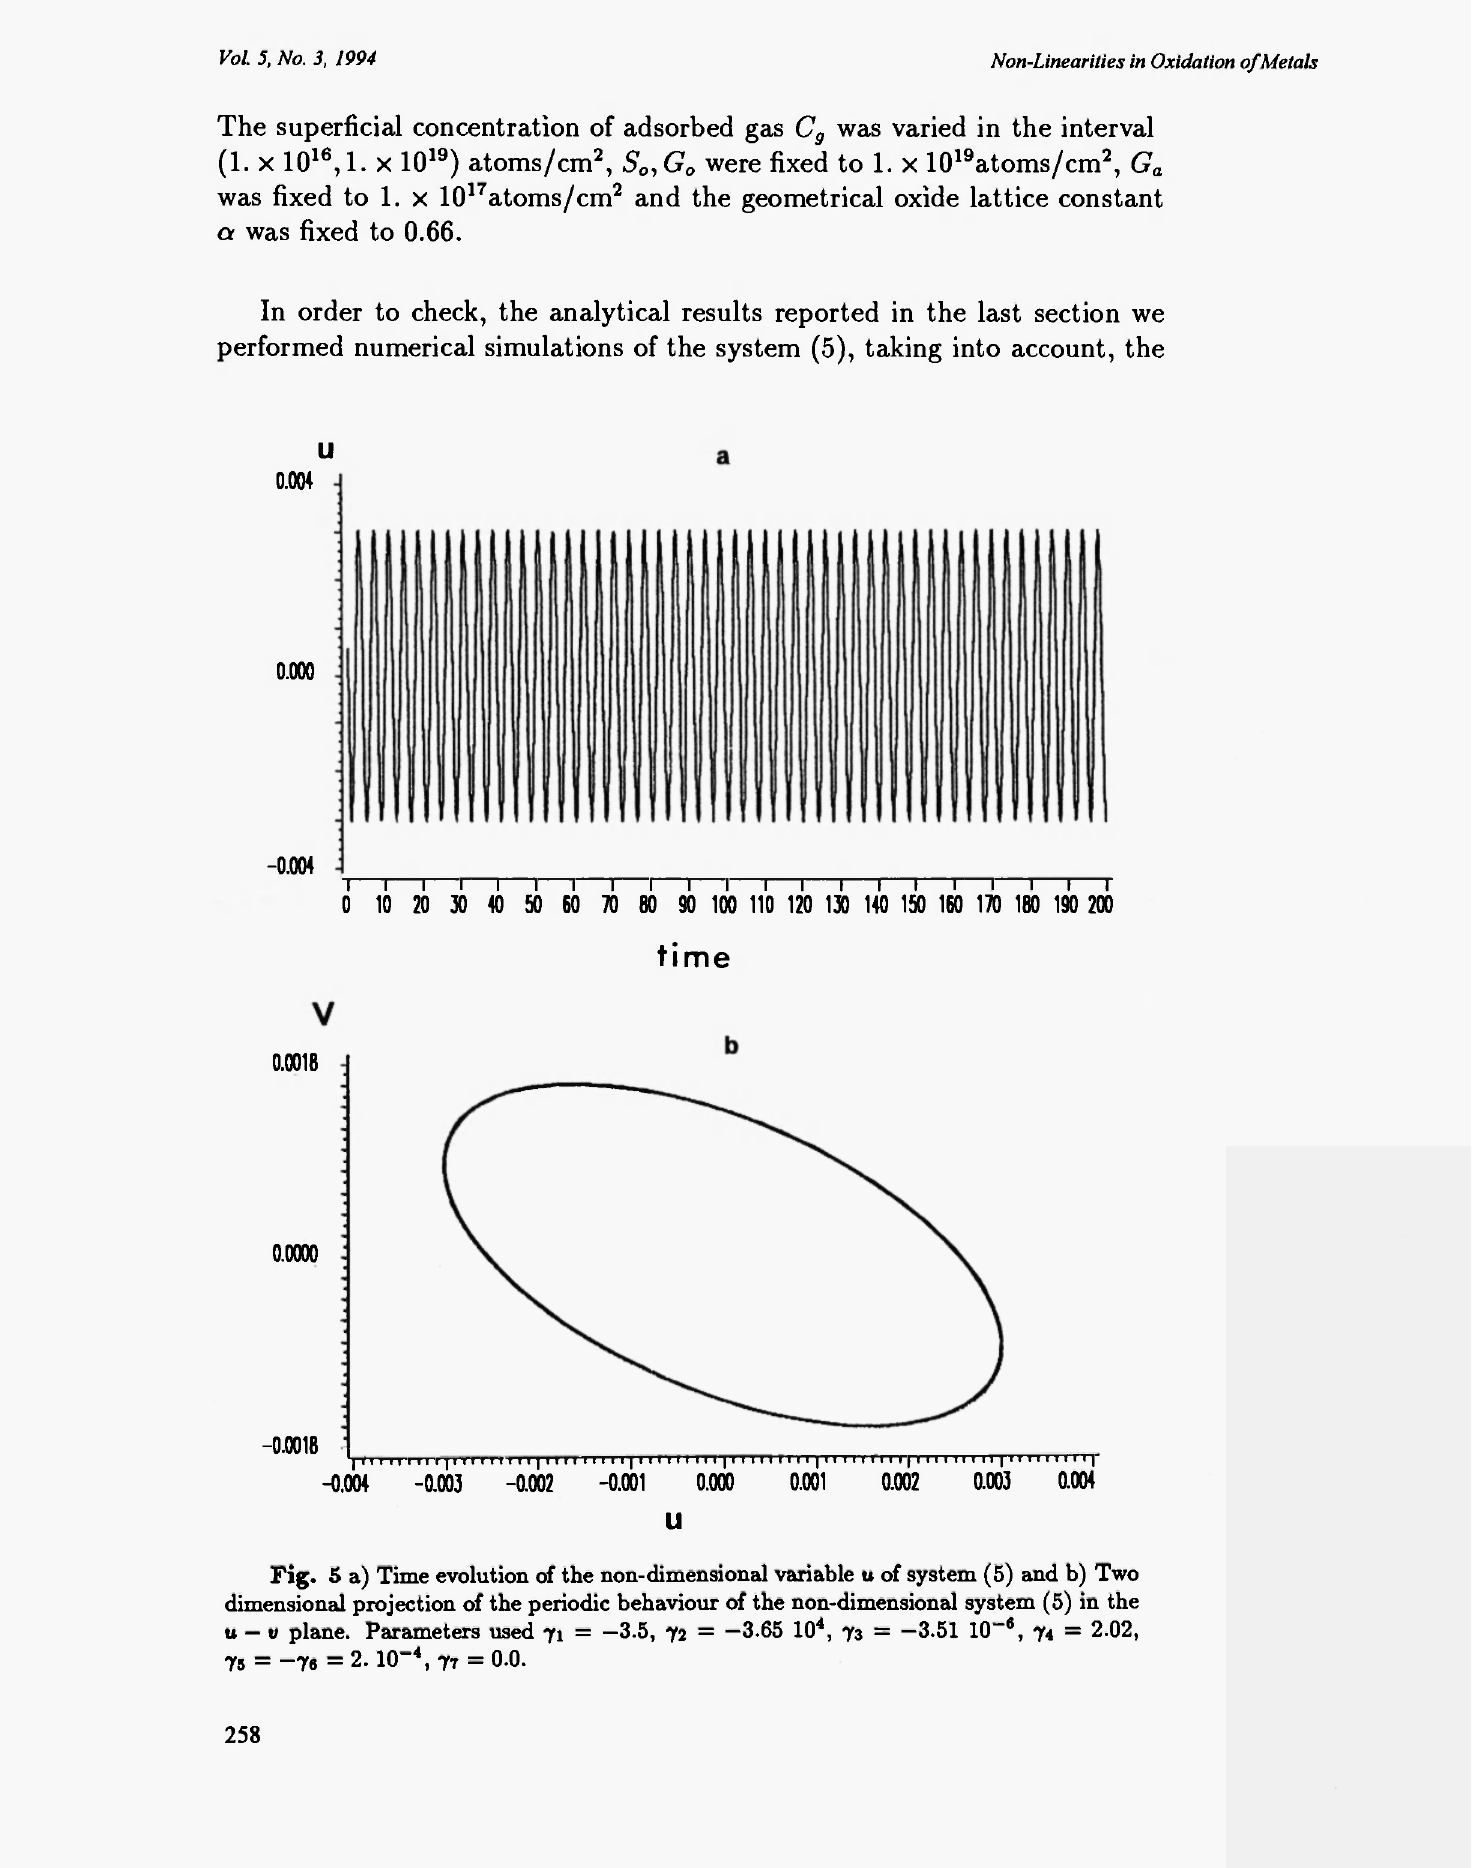
Fig. 5 a) Time evolution of the non-dimensional variable u of system (5) and b) Two dimensional projection of the periodic behaviour of the non-dimensional system (5) in the u — ν plane. Parameters used γι = -3.5, γ 2 = -3.65 10 4 , y 3 = -3.51 10 -β , 74 = 2.02, 75 = -76 = 2. ΙΟ- 4 , 77 =